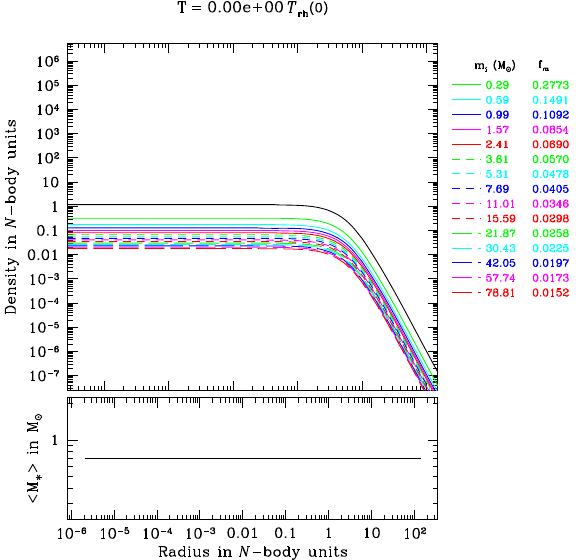
Fig. 32 Initial density profile for a stellar cluster with 15 components (upper panel) in N -body units and average total stellar mass in M (cid:2) (lower panel)